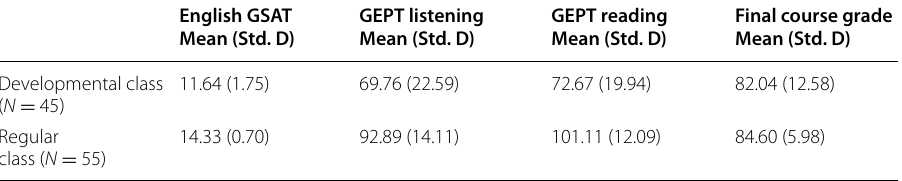
Table 4 Descriptive statistics of the English GSAT, GEPT, and final course grades English GSAT Mean (Std.